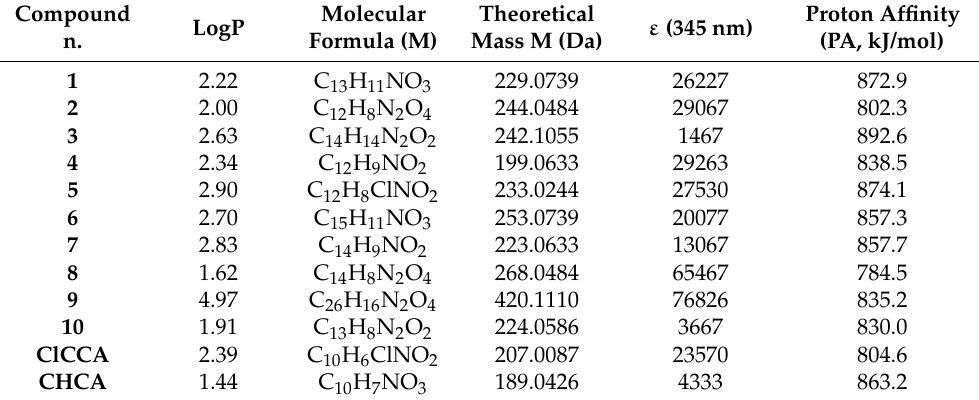
Table 1. Summary of the accessible physicochemical information of each compound retrieved from ChemDraw software. The last columns referred to PA theoretically calculated as explained in the text. The molar extinction coefficient was estimated at 345